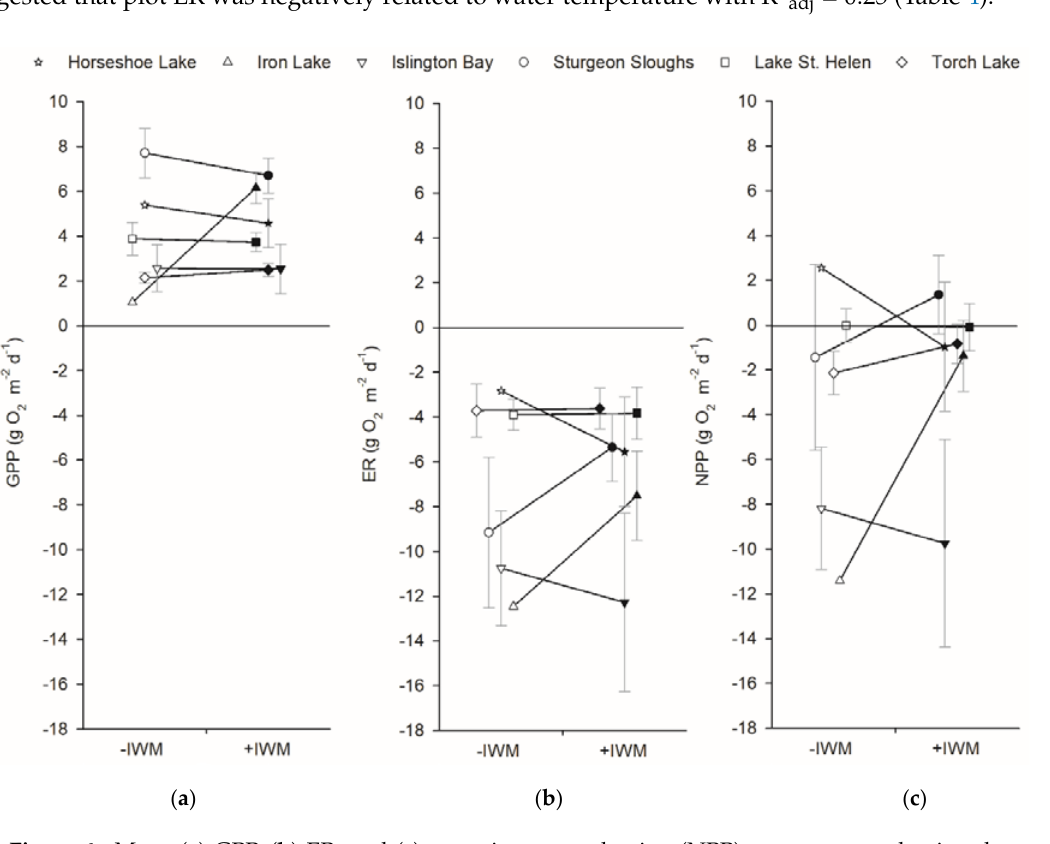
Figure 6. Mean ( a ) GPP, ( b ) ER, and ( c ) net primary production (NPP) rates measured using the open-water technique and averaged over deployment periods. Means ± 1 SE are represented by symbols with error bars. Shaded symbols represent + IWM plots and unshaded symbols represent − IWM plots for each waterbody. Lines connecting symbols illustrate differences in paired plots. Symbols are offset horizontally to aid in interpretation of error bars.